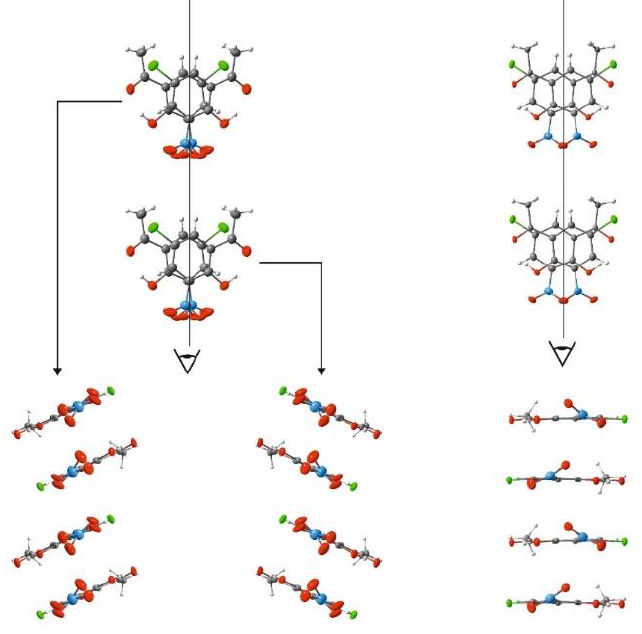
Figure 2. Selected view of the molecular packing of polymorph I (left side) and polymorph II (right side).